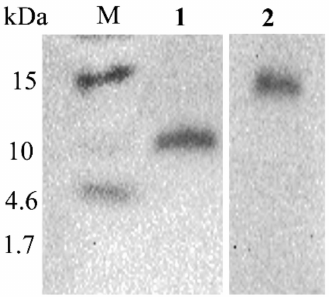
Figure 5. Western blot analysis of fusion